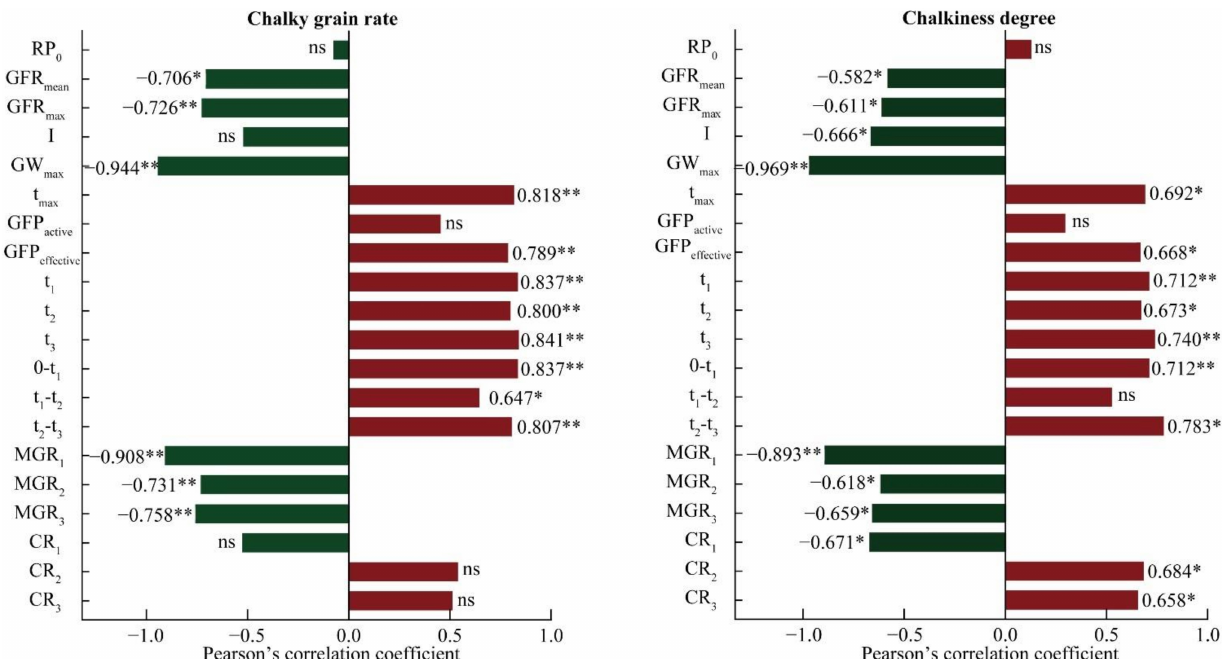
Figure 5. Relationships between chalkiness and rice grain filling characteristic ( n = 12). RP 0 , relative initial growth potential; GFR mean , mean grain filling rate; GFR max , maximum grain filling rate; I, grain weight at maximum grain filling rate/maximum grain weight; GW max , grain weight at maximum grain filling rate; t max , time to reach the maximum filling rate; GFP active , active grain filling period; GFP effective , effective grain filling period; 0–t 1 , early period; t 1 –t 2 , middle period; t 2 –t 3 , late period; MGR 1 , mean grain filling rate during the early period; MGR 2 , mean grain filling rate during the middle period; MGR 3 , mean grain filling rate during the late period; CR 1 , contribution rate of the early period; CR 2 , contribution rate of the middle period; CR 3 , contribution rate of the late period; * p < 0.05; ** p <